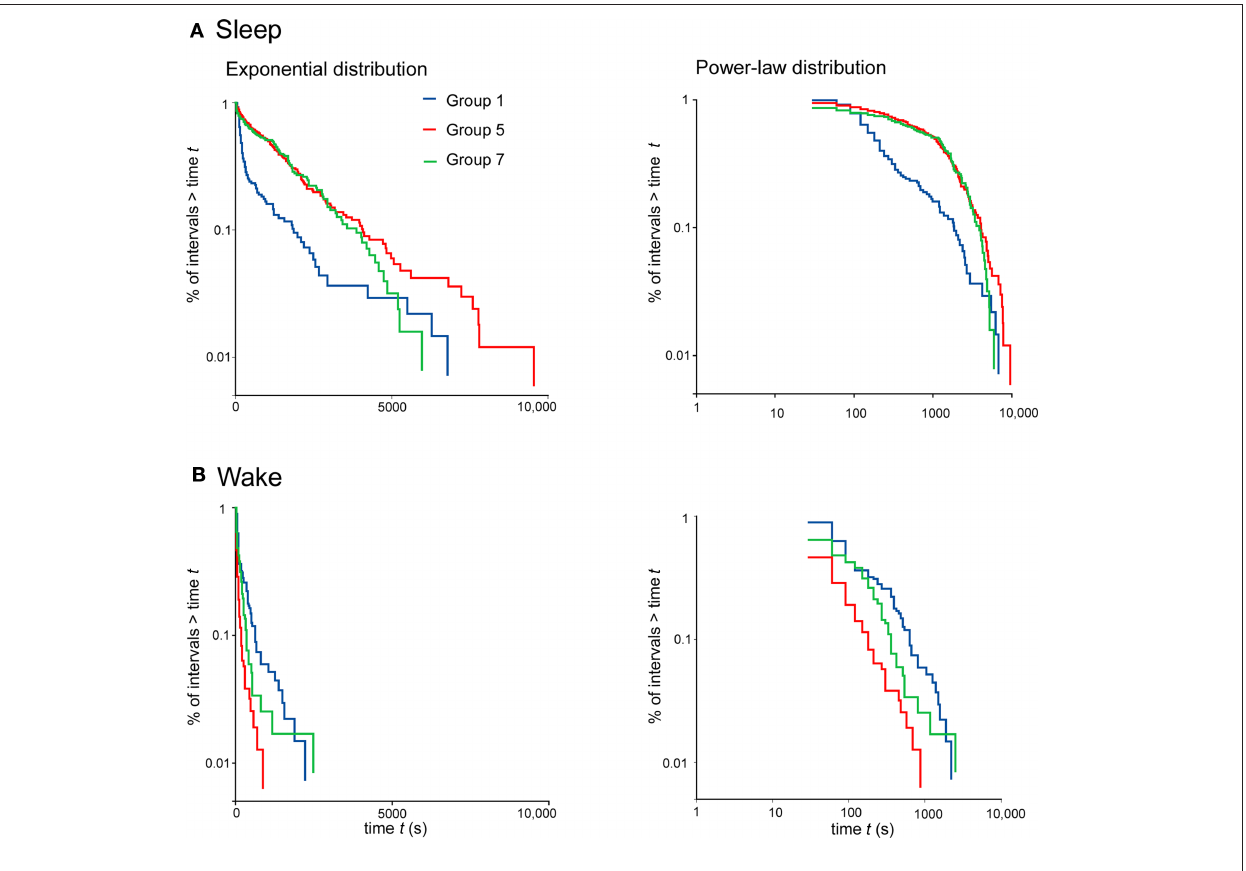
diagonal lines on these plots indicate an exponential distribution of bout lengths. On the right, plots constructed using log-log coordinates are depicted: straight diagonal lines on these plots indicate a power-law